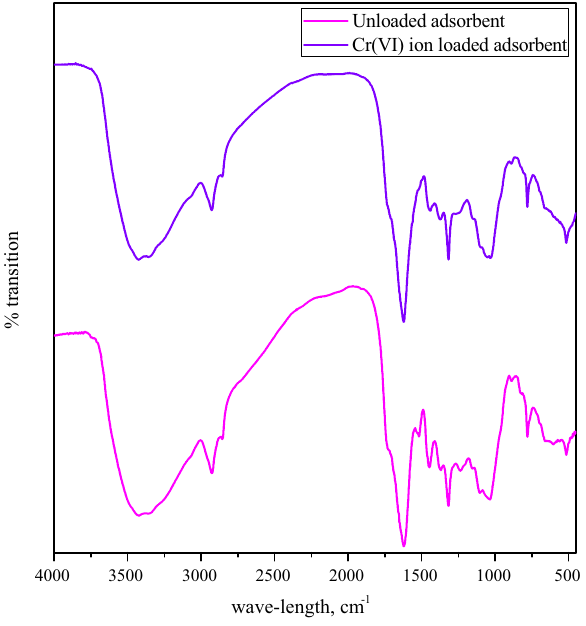
Fig. 5 Effect of flow rate for Cr(VI) ion